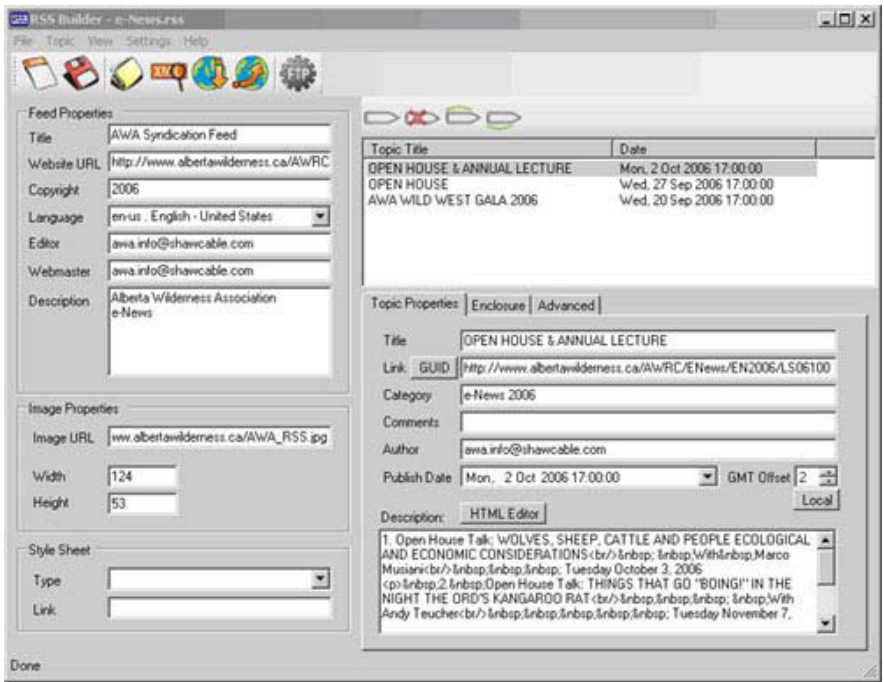
Figure 2. RSS Builder main work area with sample data. The left area depicts channel information (labeled as Feed Properties), while the right area is focused on item elements (designated as Topic